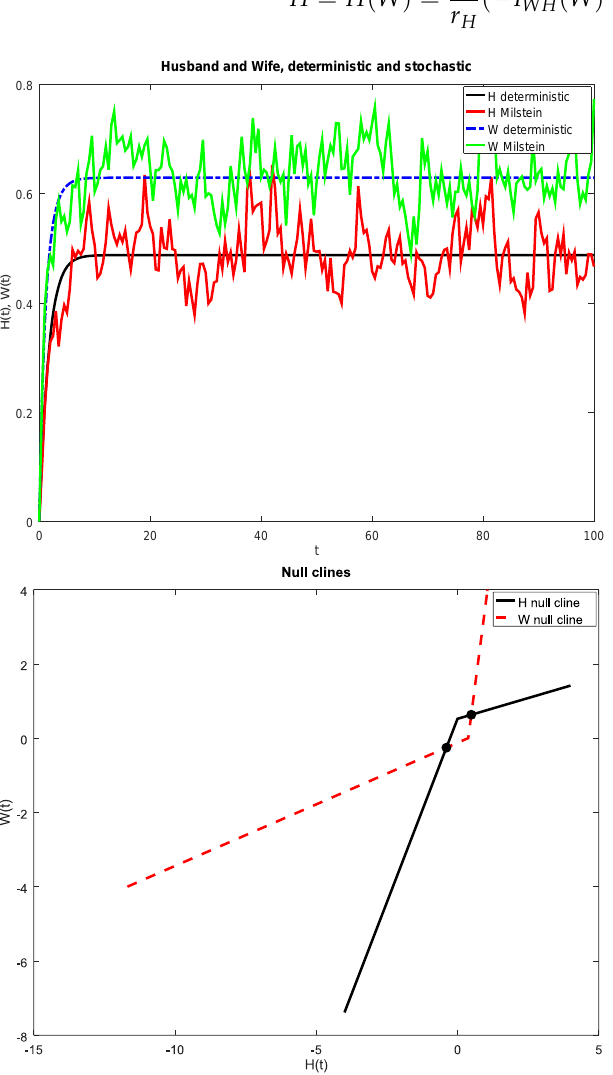
Figure 6. Bilinear influence functions. Plot of H and W vs. time for the deterministic case and a stochastic realization ( top ) and a plot of the nullclines and the equilibrium points ( bottom ). In this example, the external noise only makes the satisfaction oscillate around the equilibrium state of the deterministic